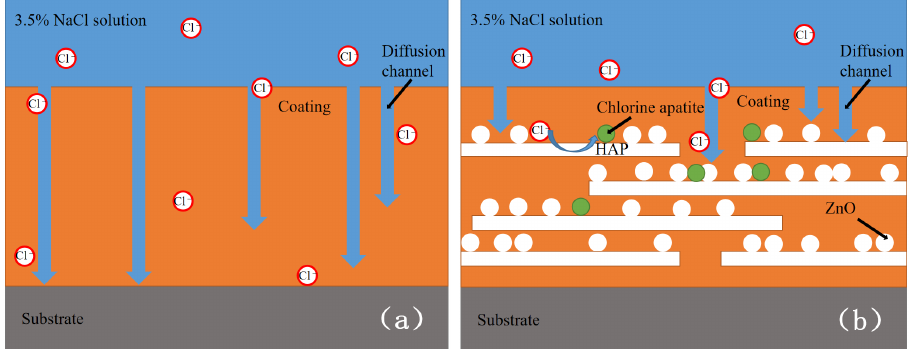
Figure 15. Anti-corrosion mechanism diagram of coatings: ( a ) epoxy resin and ( b ) 65 wt.% ZnO + 35 wt.% HAP.